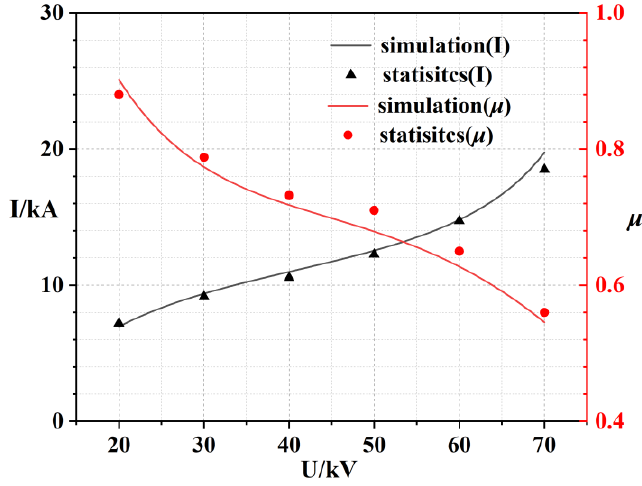
Figure 14. 100cm gap μ and I actual and theoretical value comparison diagram. Figure 14. 100 cm gap µ and I actual and theoretical value comparison